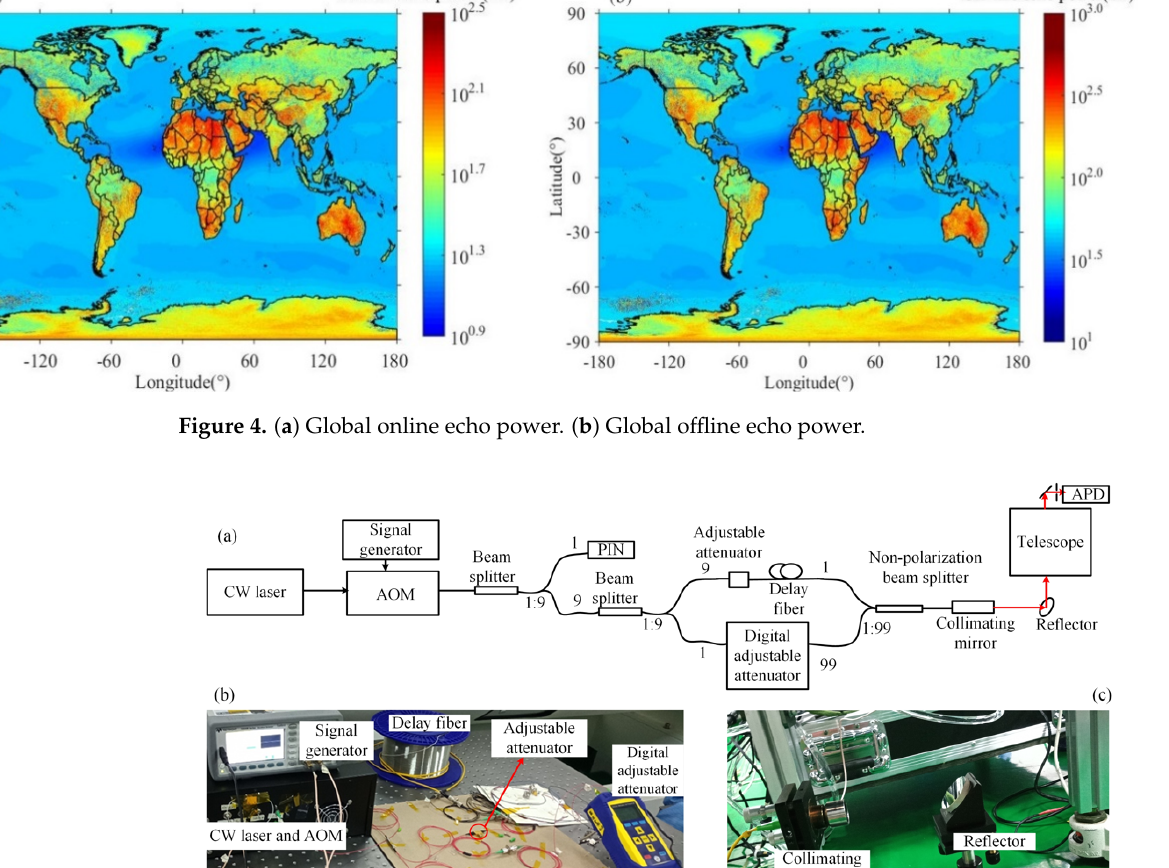
Figure 5. ( a ) Schematic diagram of detector linearity test setup. ( b ) The instruments used for the experiment. ( c ) The instruments used for the experiment.